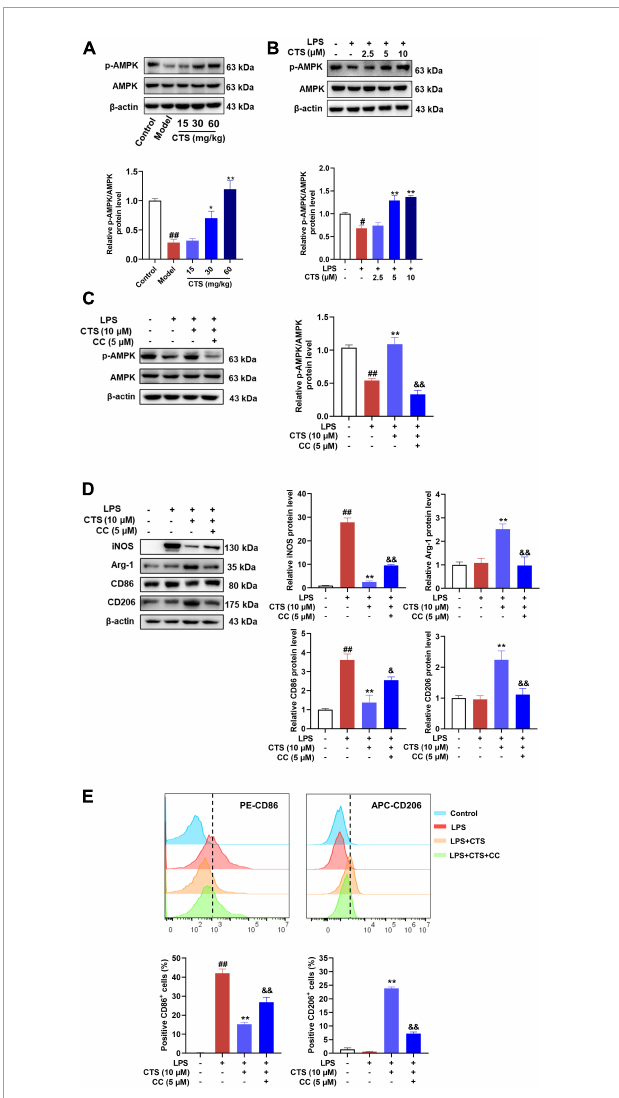
FIGURE5 Cryptotanshinone (CTS) regulates RAW264.7 macrophage polarization via AMPK. (A) The protein levels of p-AMPK/AMPK in LPS-induced acute lung injury were analyzed by western blot, n = 4. (B) The protein expression of p-AMPK/AMPK in LPS-treated macrophage was analyzed by western blot, n = 3. (C-E) RAW264.7 pretreated with 5? µ M AMPK inhibitor compound C for 2 h were treated with 10 µ M CTS for 2?h and then exposed to LPS for another 24 h. (C) The protein expression levels of p-AMPK/AMPK were assessed by western blot analysis, n = 3. (D) The protein expression of iNOS, Arg-1, CD86, and CD206 was detected by Western blot, n = 3. (E) The proportion of CD86 + cells and CD206 + cells were analyzed by flow cytometry, n = 3. Data were presented as the mean ± SEM. # P < 0.05, ## P < 0.01 vs. the control group; * P < 0.05, ** P < 0.01 vs. the LPS